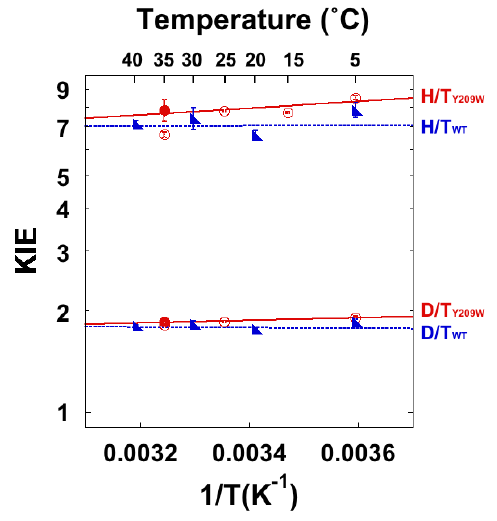
Figure 6. Observed (empty circles) and intrinsic (filled circles) KIEs on the hydride transfers in the wt (blue triangles) and Y209W (red circles). Reproduced with permission from ref.